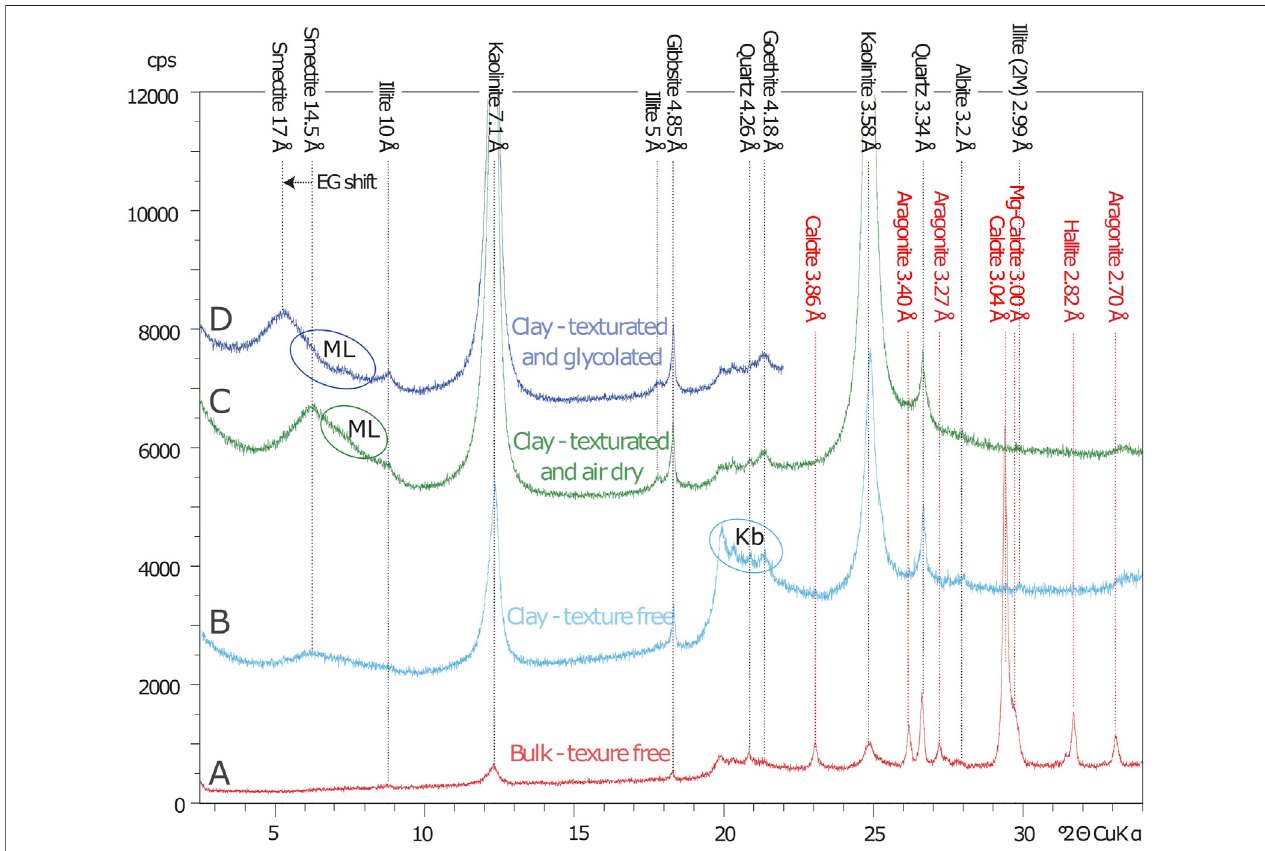
FIGURE 3 | Diffractogram showing the result of the four different preparation methods at one sample (Nr. 480). The y scale is to be viewed relatively within each measurement and does not indicate absolute values or relative intensities between different measurement types. (A) The bulk texture-free samples indicate the carbonate peaks, some halite, as well as quartz and low albite content. (B) Peaks from other phases, such as goethite and clay minerals are more distinctly seen in the texture-free measurements conducted on the decarbonized clay fraction. In curve B several high peaks at 20 – 21.5 ° 2 Θ are re fl ections from kaolinites with b-axis variabilities(Kb). (C) Due tothe sheet like crystal habit ofclayminerals, their diffraction peaks are most intense, and thus bestmeasurable, in the textured preparation. At around7 ° 2 Θ re fl ectionsfrommixedlayerminerals(ML)aredetectablebetweenthesmectiteandillitepeak. (D) Tominimizethepossibleinterferenceofthesemixedlayer minerals with the illite and smectite peaks and to reliably identify the expandablesmectite phase, the textured clay fraction samples are remeasured after exposureto an ethylene glycol (EG) atmosphere.